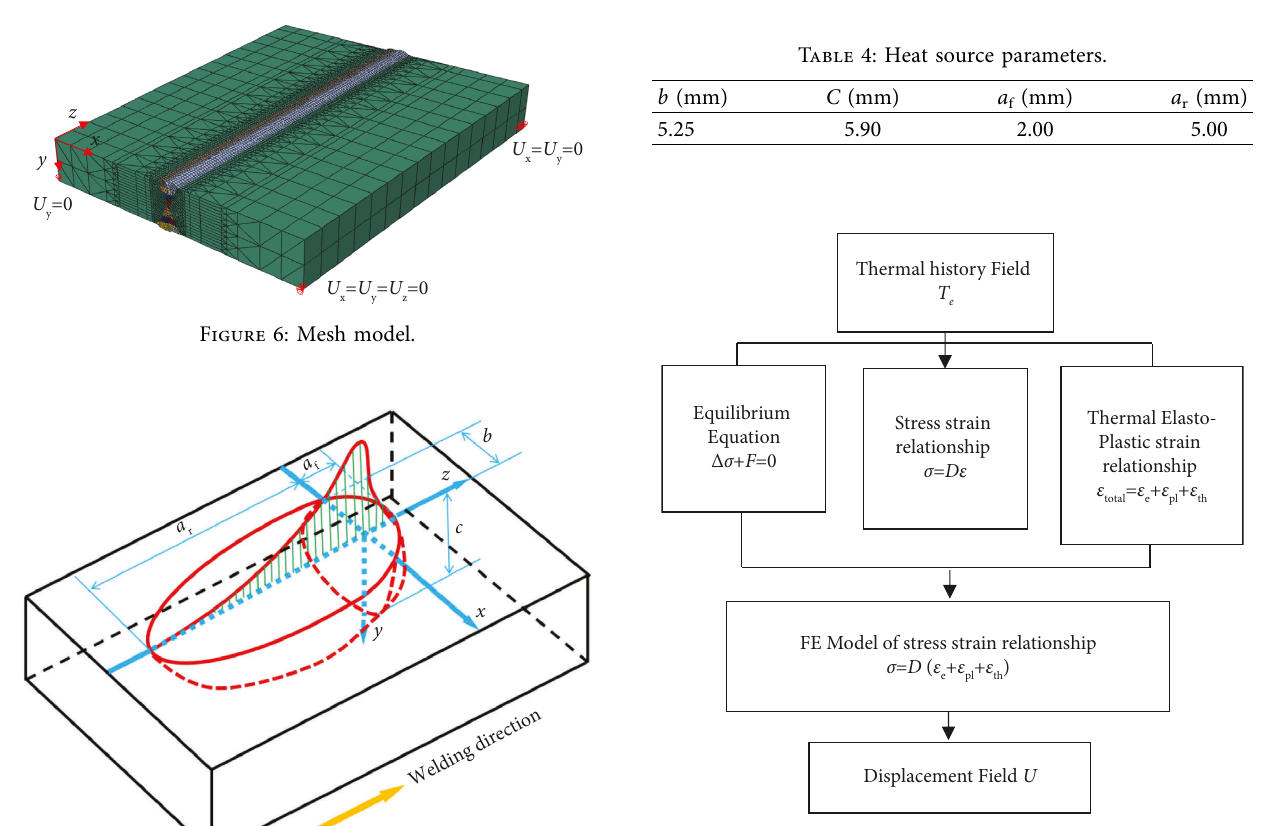
Figure 8: Flow chart of finite element mechanical